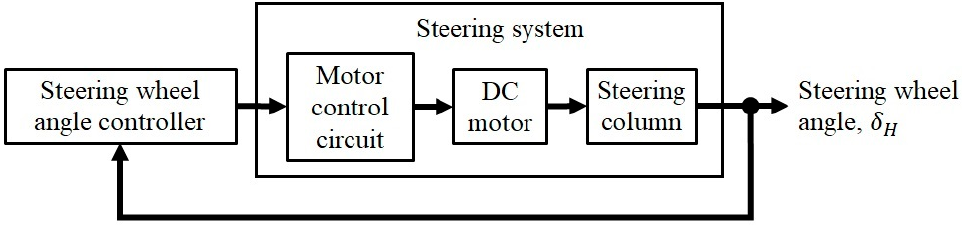
Figure 3. Static steering assistance control system model with steering wheel angle controller and steering system.